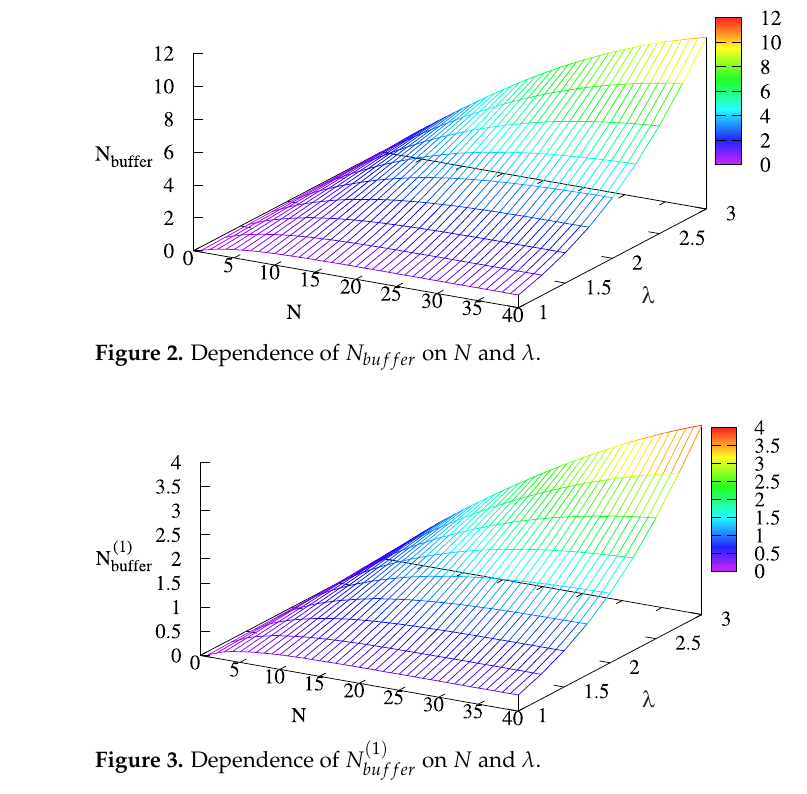
Figure 3. Dependence of N